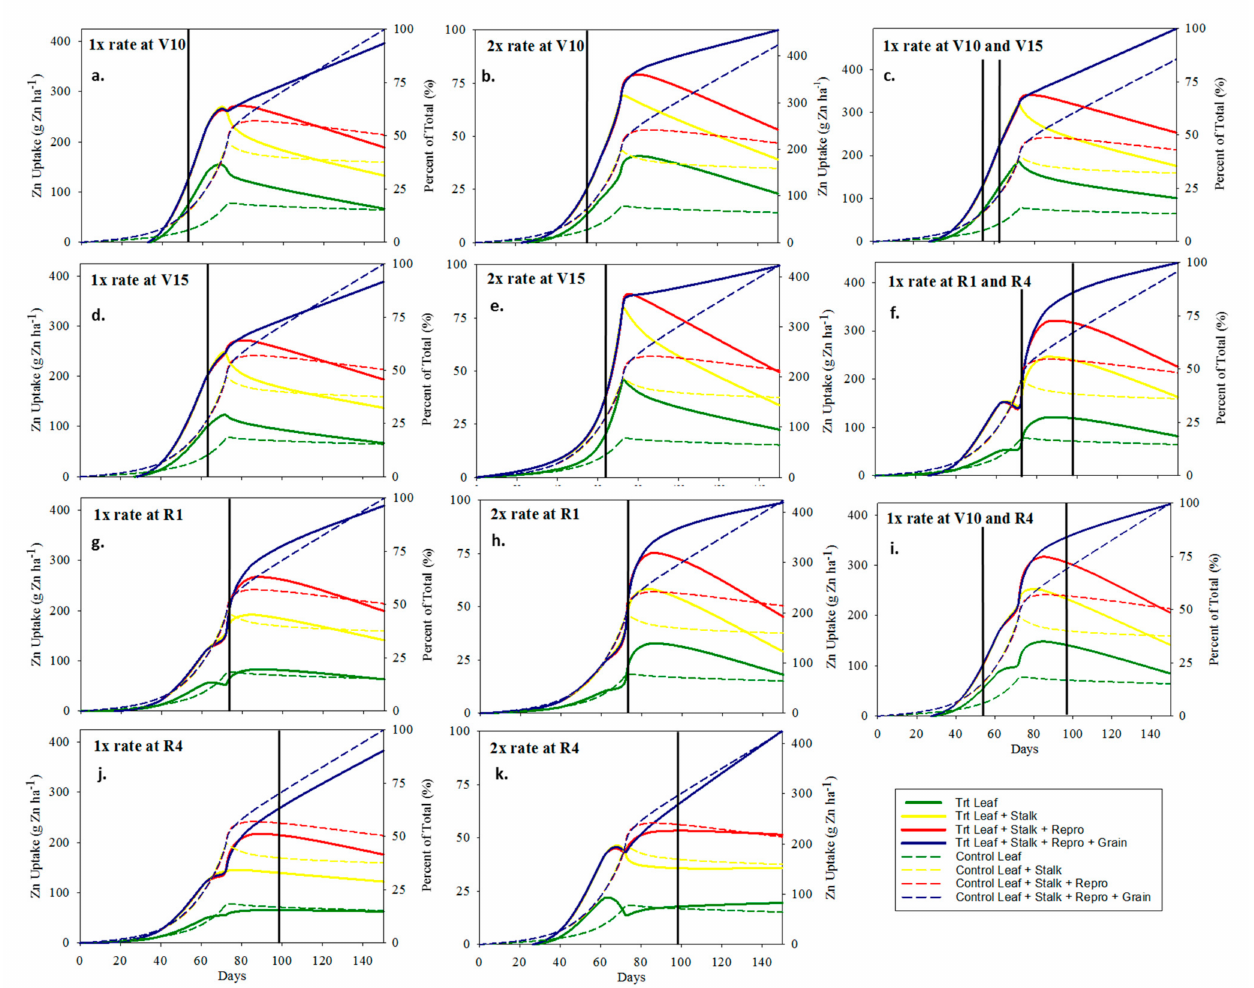
Figure 6. Zn uptake (g Zn ha − 1 ) and partitioning graphs. Solid and dashed lines represent foliar Fe/Zn treated plots and control plot, respectively. Solid vertical lines represent the time of application expressed as days after sowing. ( a – k ) corresponds with the